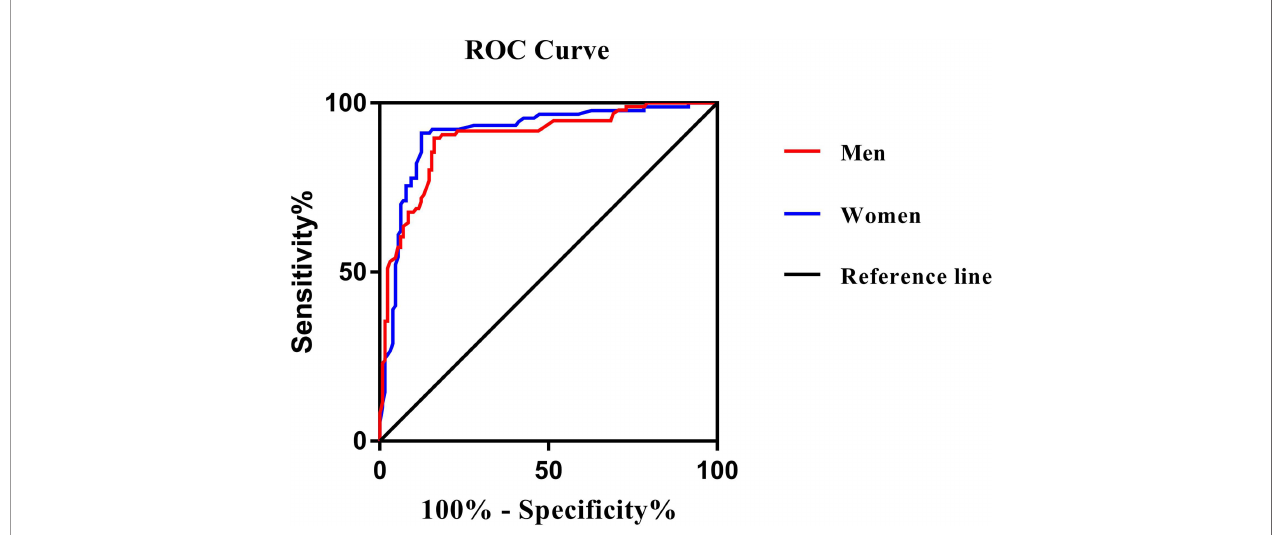
FIGURE 3 | Receiver operating characteristic curves for the cutoff value of PrFT to identify MetS. In men, the area under the curve was 0.895 (95% CI: 0.852 – 0.939). In women, the area under the curve was 0.910 (95% CI: 0.876 – 0.953). The optimal cutoff values of PrFT were 14.6 mm (sensitivity: 83.8%, speci fi city: 89.6%) for men and 13.1 mm (sensitivity: 87.6%, speci fi city: 91.1%) for